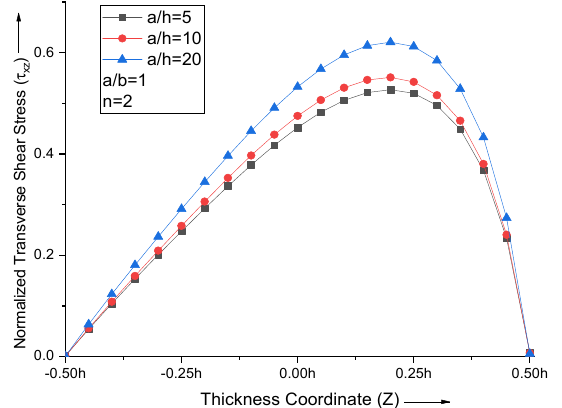
ary condition and the maximum displacement can be observed at the center of the plate.